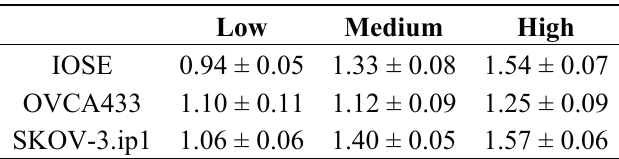
Table 7. Ratio of focal adhesion overlap on LN gradients vs. BSA background for the cells lines on the low slope gradient. The ratios for the IOSE and SKOV-3 cells were different at the three concentration regions. The OVCA433 data were not different from each other were all greater than unity. Focal adhesions from 16–20 cells are analyzed per region and the errors are mean